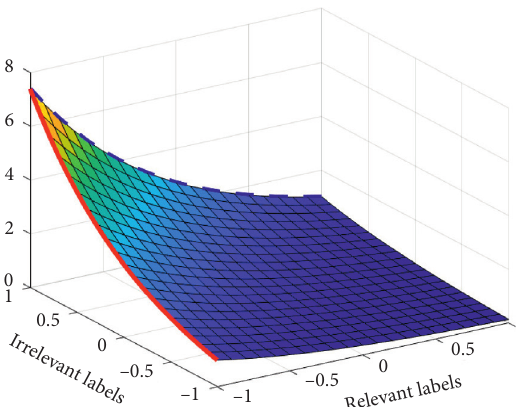
Figure 5: The error function of BP-MLL